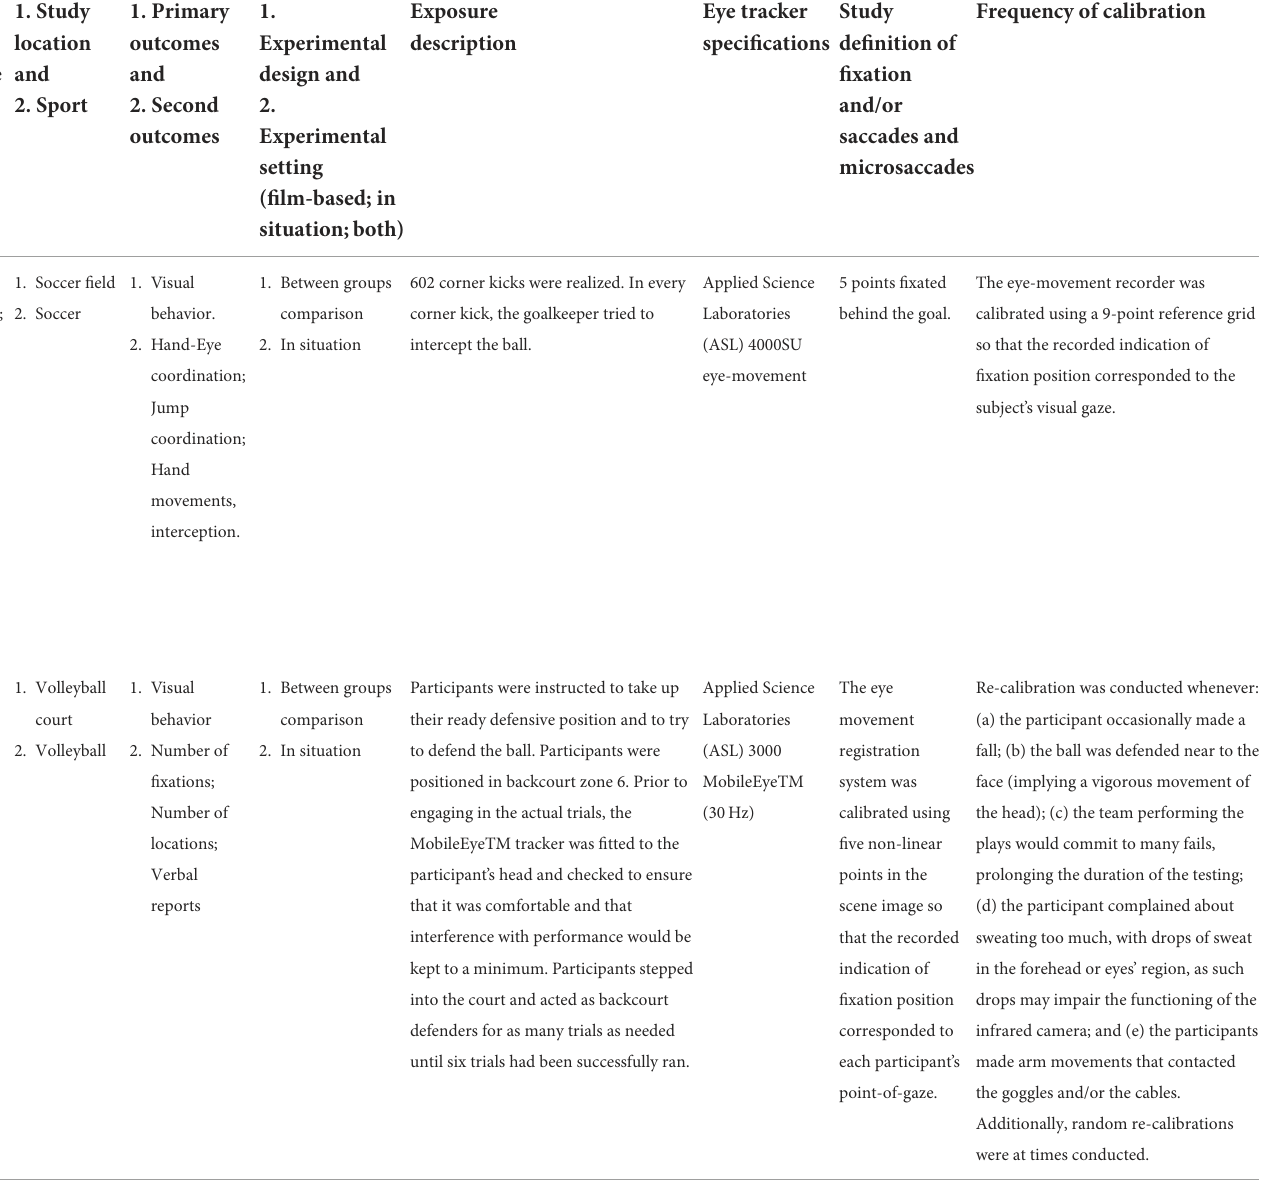
TABLE 2 Study characteristics and main